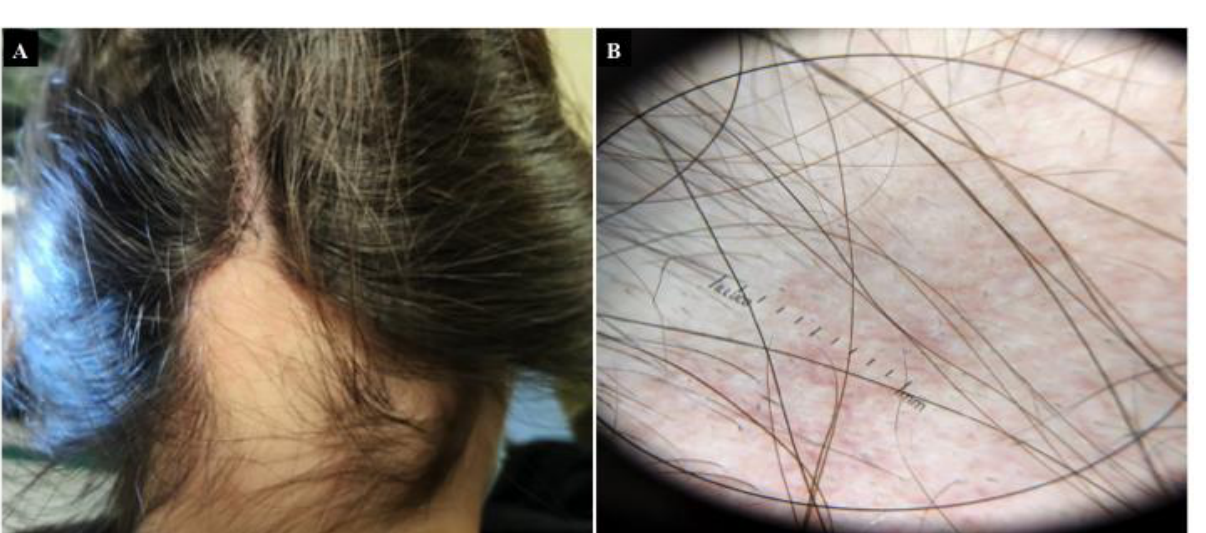
Figure 2. Alopecia Areata. ( A ) nonscarring hair loss in a 16 year old woman with onset diagnosis of Celiac Disease. ( B ) Dermoscopic image with a magnification 20 × : dermoscopic features in alopecia areata are black dots (cadaverous hairs), yellow dots, tapering hairs (exclamation mark hairs), and broken hairs.